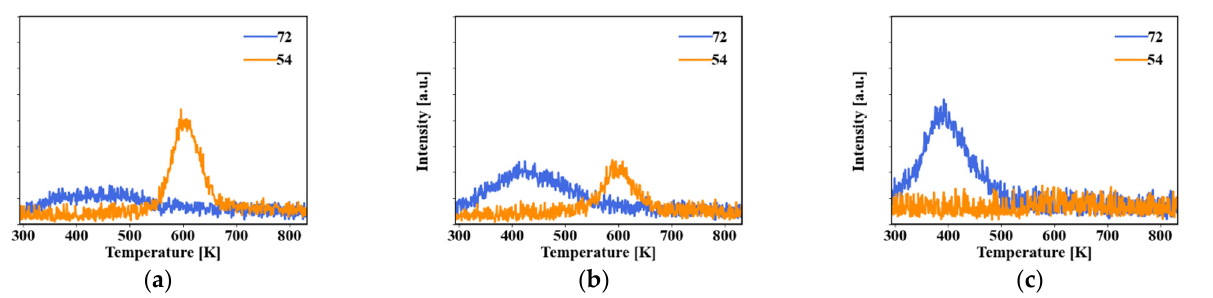
Figure 3. TPD data for the reaction of THF on ( a ) ZrO 2 ( b ) 1 wt% Na-ZrO 2 ( c ) 2 wt% Na-ZrO 2 : THF- m/e 72; 1,3-butadiene-m/e 54.